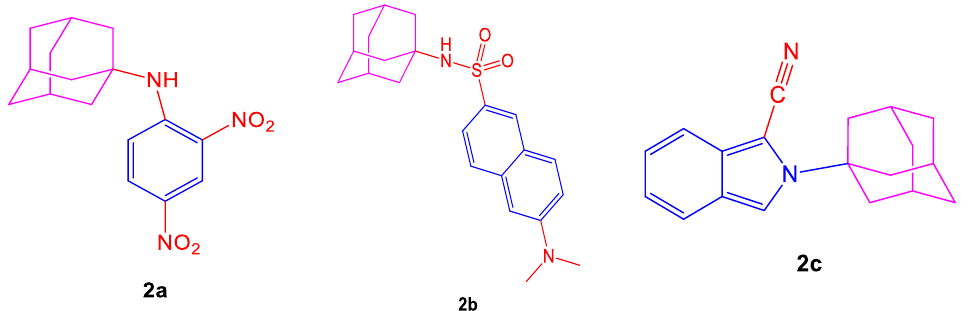
Figure 2. Structures of compounds ( 2a – c ) having antioxidant activities